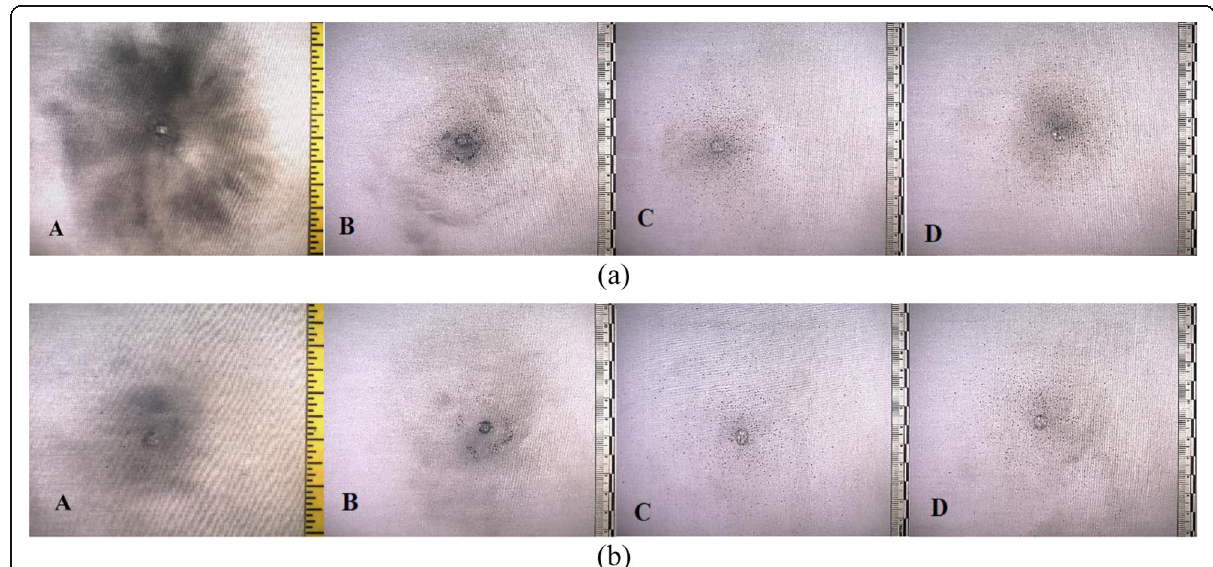
Fig. 3 Pattern distribution of soot and GSR particles: In the x -axis scale: (A_.38SME), (B_.38SME), (C_9SME) and (D_9SME). In the y -axis scale: shooting distances of a 9 cm and b 15